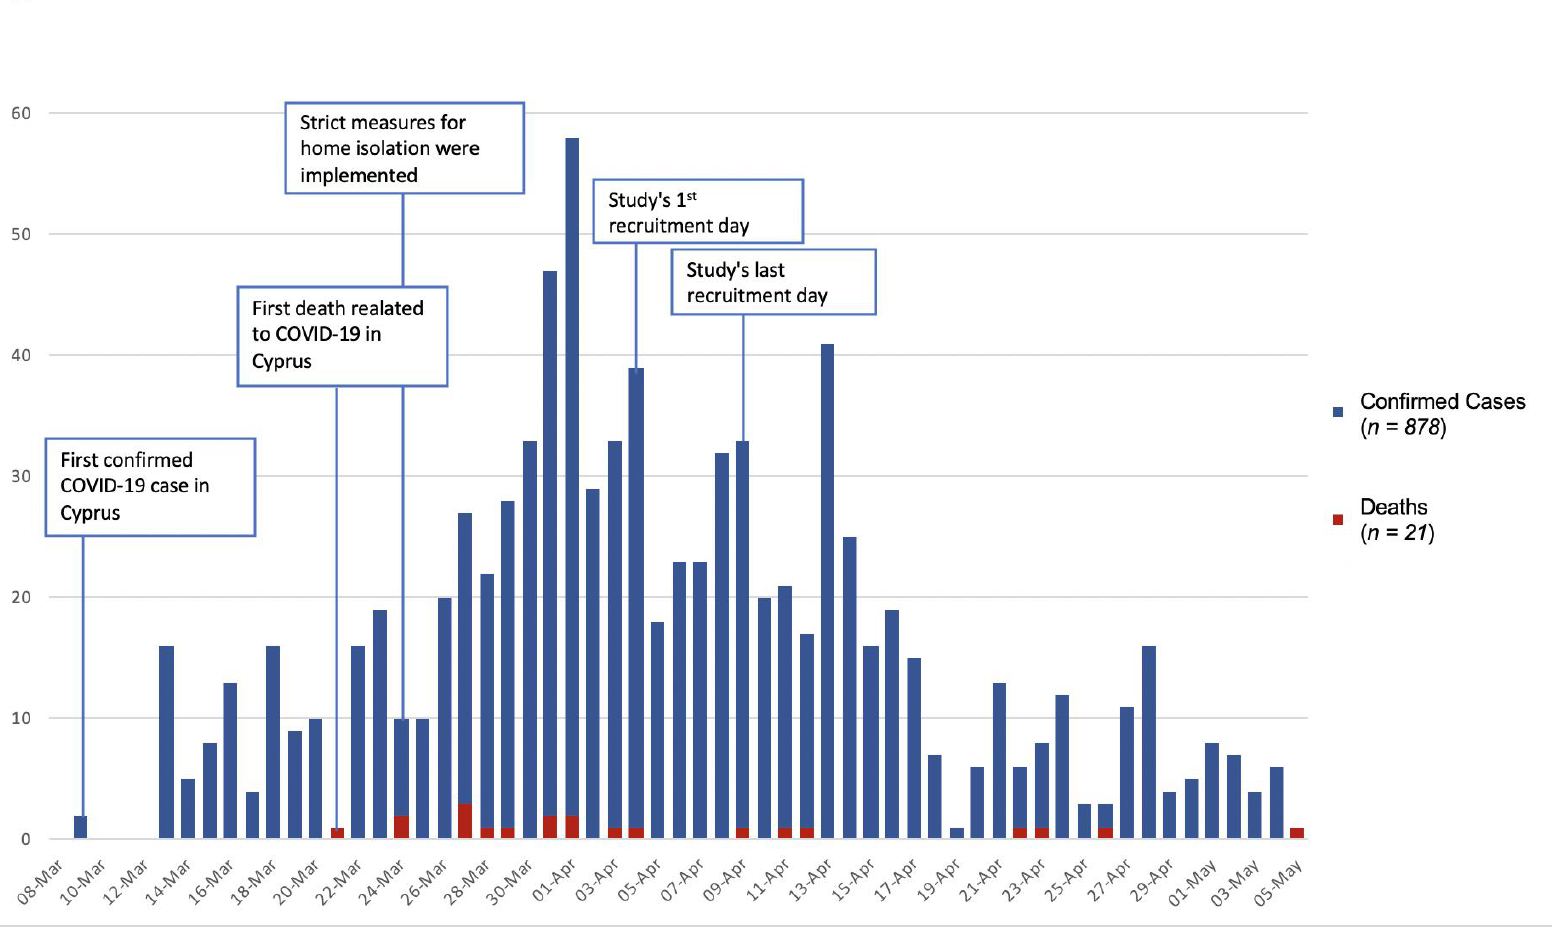
Figure 1. Epidemic trend of Severe Acute Respiratory Syndrome Coronavirus 2 (also known as COVID-19) outbreak in Cyprus from 8 March to 5 May.